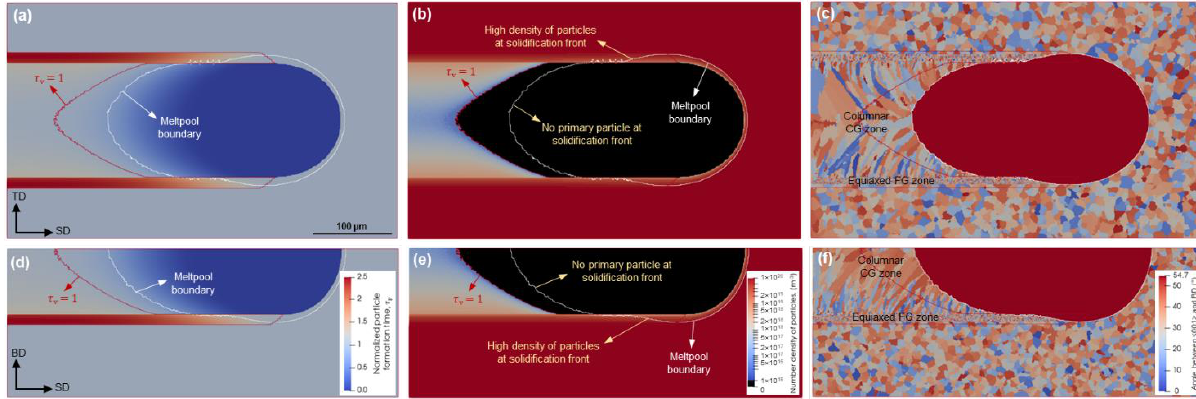
Figure 8. CA simulations of particle and microstructure evolution at a scanning speed of 1000 mm/s and a platform temperature of 298 K; distributions of normalized particle formation time 𝜏 𝑣 ( a , d ), particle number density ( b , e ), and resulting grain structure ( c , f ) on the top surface ( a – c ) and the longitudinal cross-section ( d – f ).